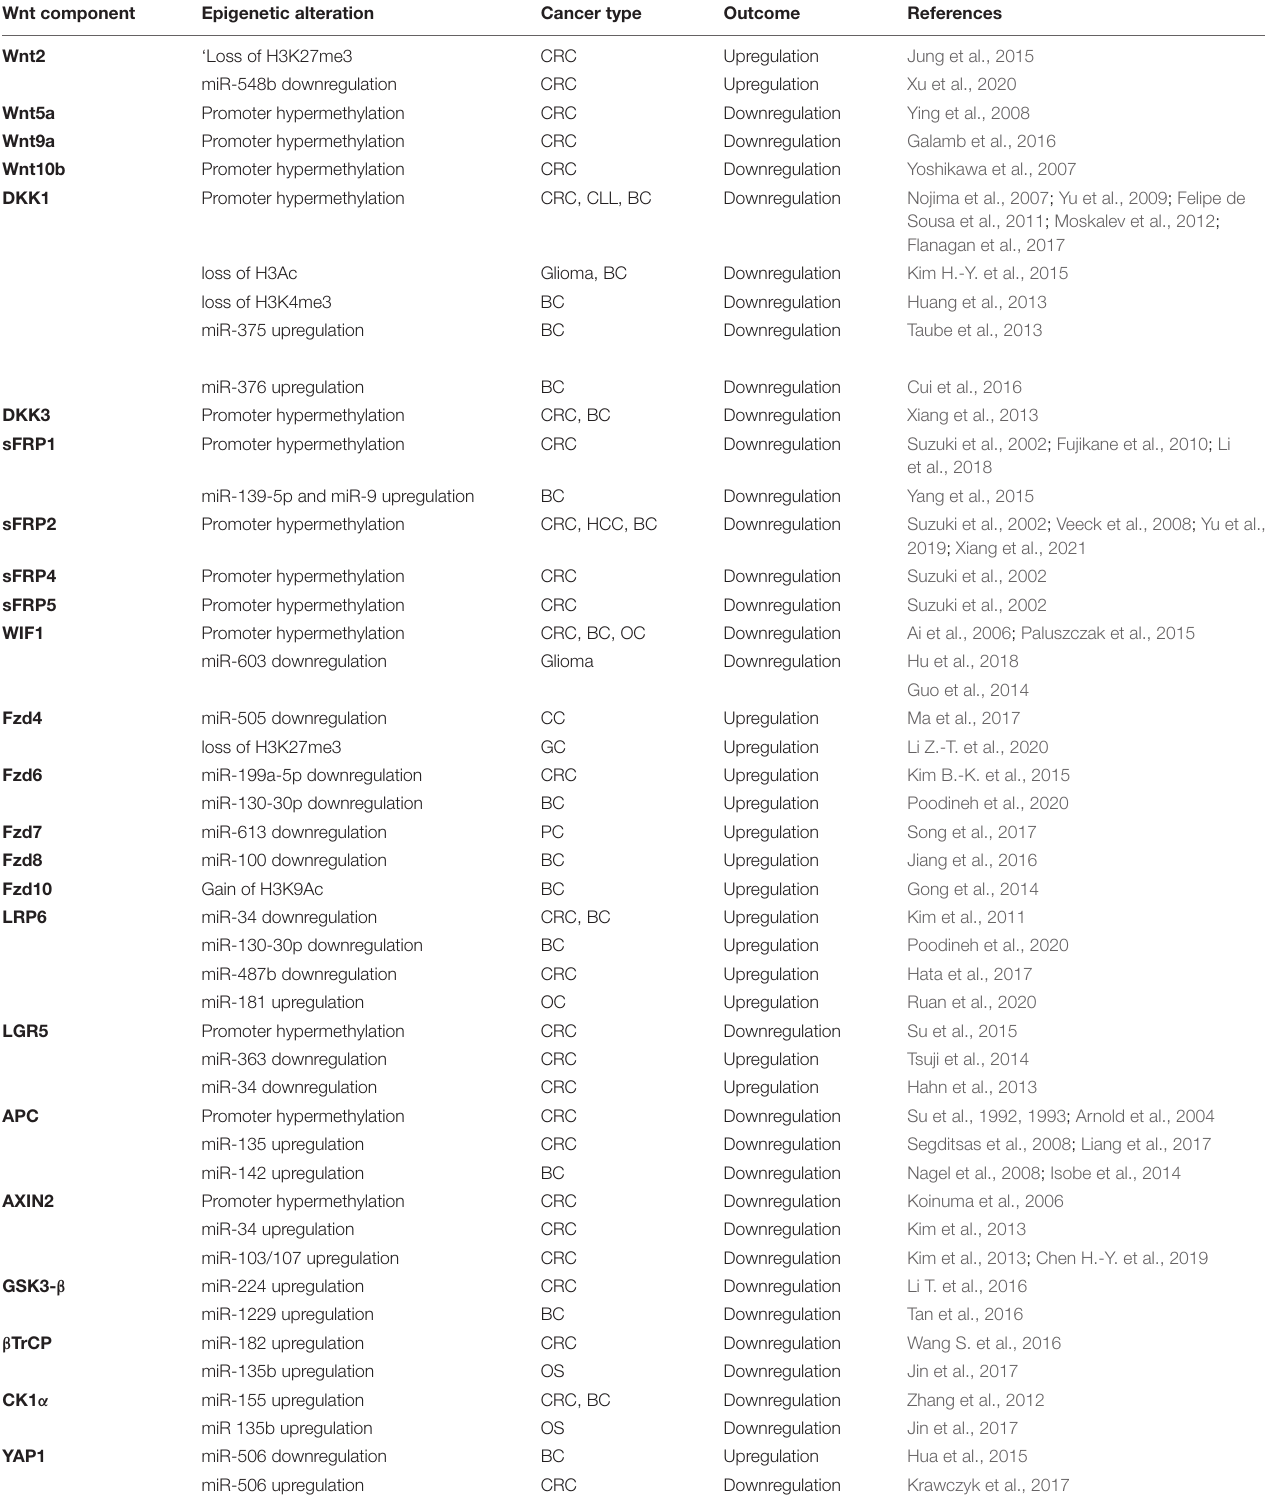
TABLE 2 | Epigenetic mechanisms regulating the Wnt components in different types of